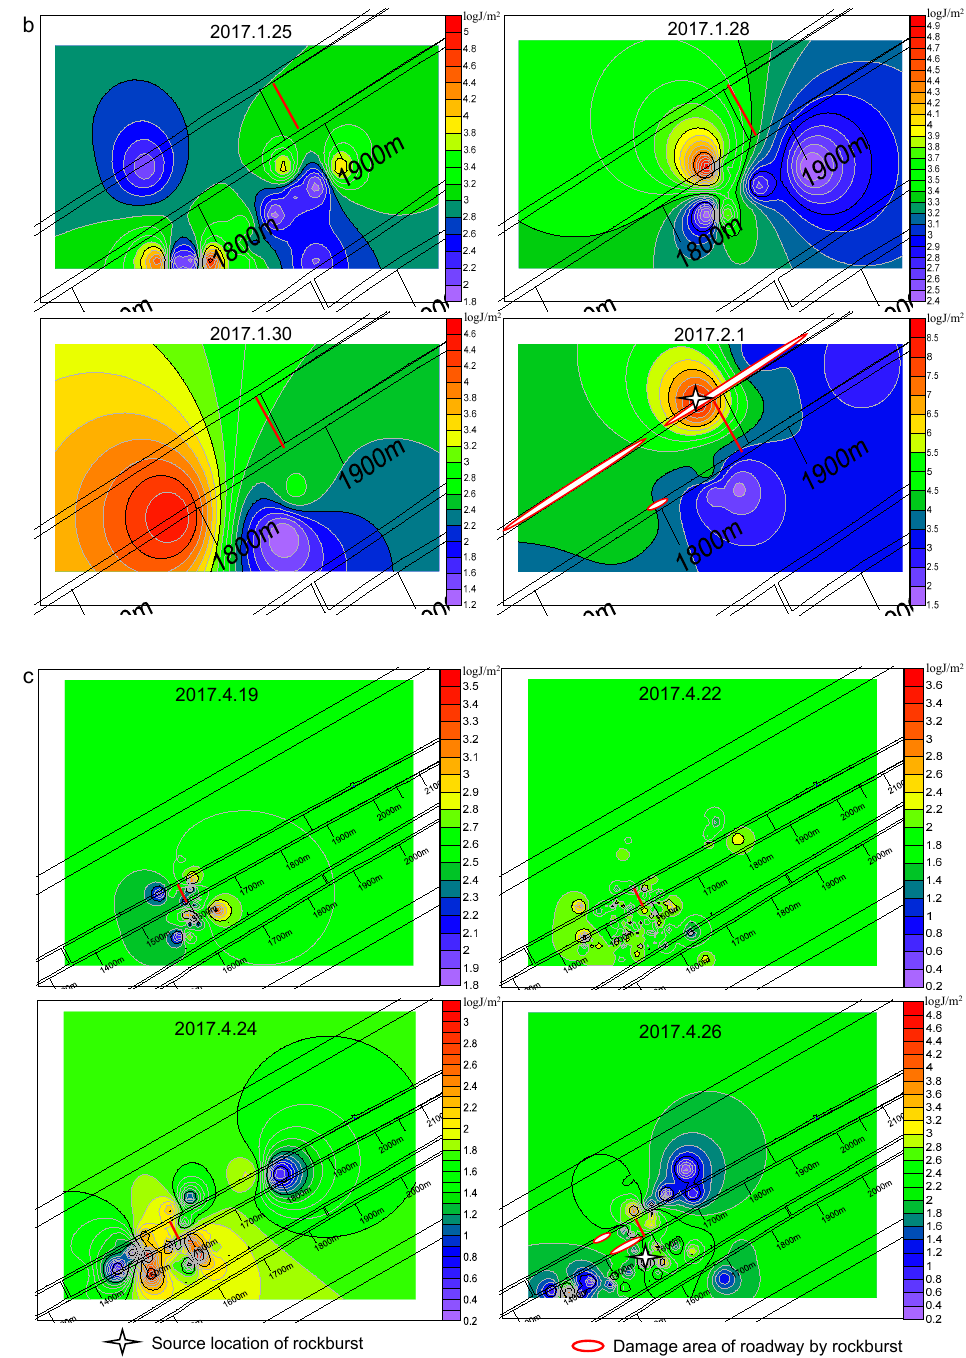
Figure 12. Spatial evolution of the EDIM before each rockburst. ( a ) “11 · 24”, ( b ) “2 · 1”, ( c ) “4 · 26”. The anomalous areas of the EDIM before the occurrence of the rockburst were con- sistent with the rockburst damaged areas and the source locations, which were located within 200 m of the working surface. It indicated that stress was mainly concentrated in these areas before rockburst occurred. The fracture strength of coal and rock and rockburst risk were high, so necessary prevention measures would be required within 200 m of the